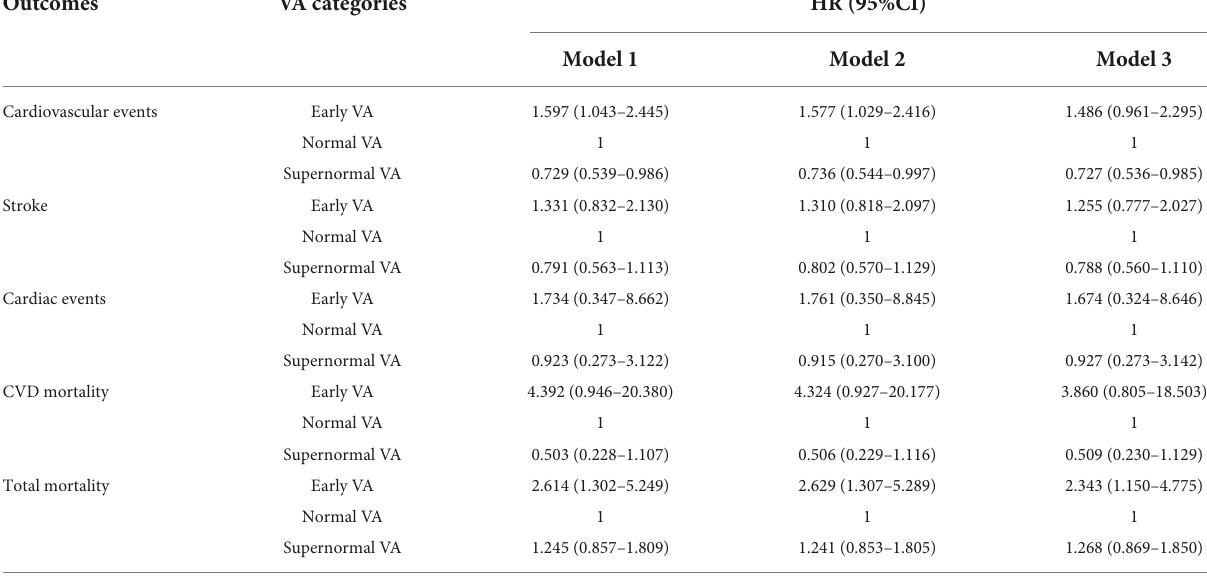
TABLE 2 Hazard ratios for vascular aging categories for total mortality, CVD, stroke, and cardiac